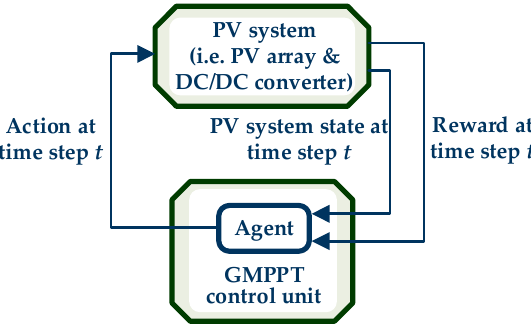
Figure 3. A simplified representation of the process implemented by the Q-learning algorithm in order to control a PV system for the implementation of the global maximum power point tracking (GMPPT) process.